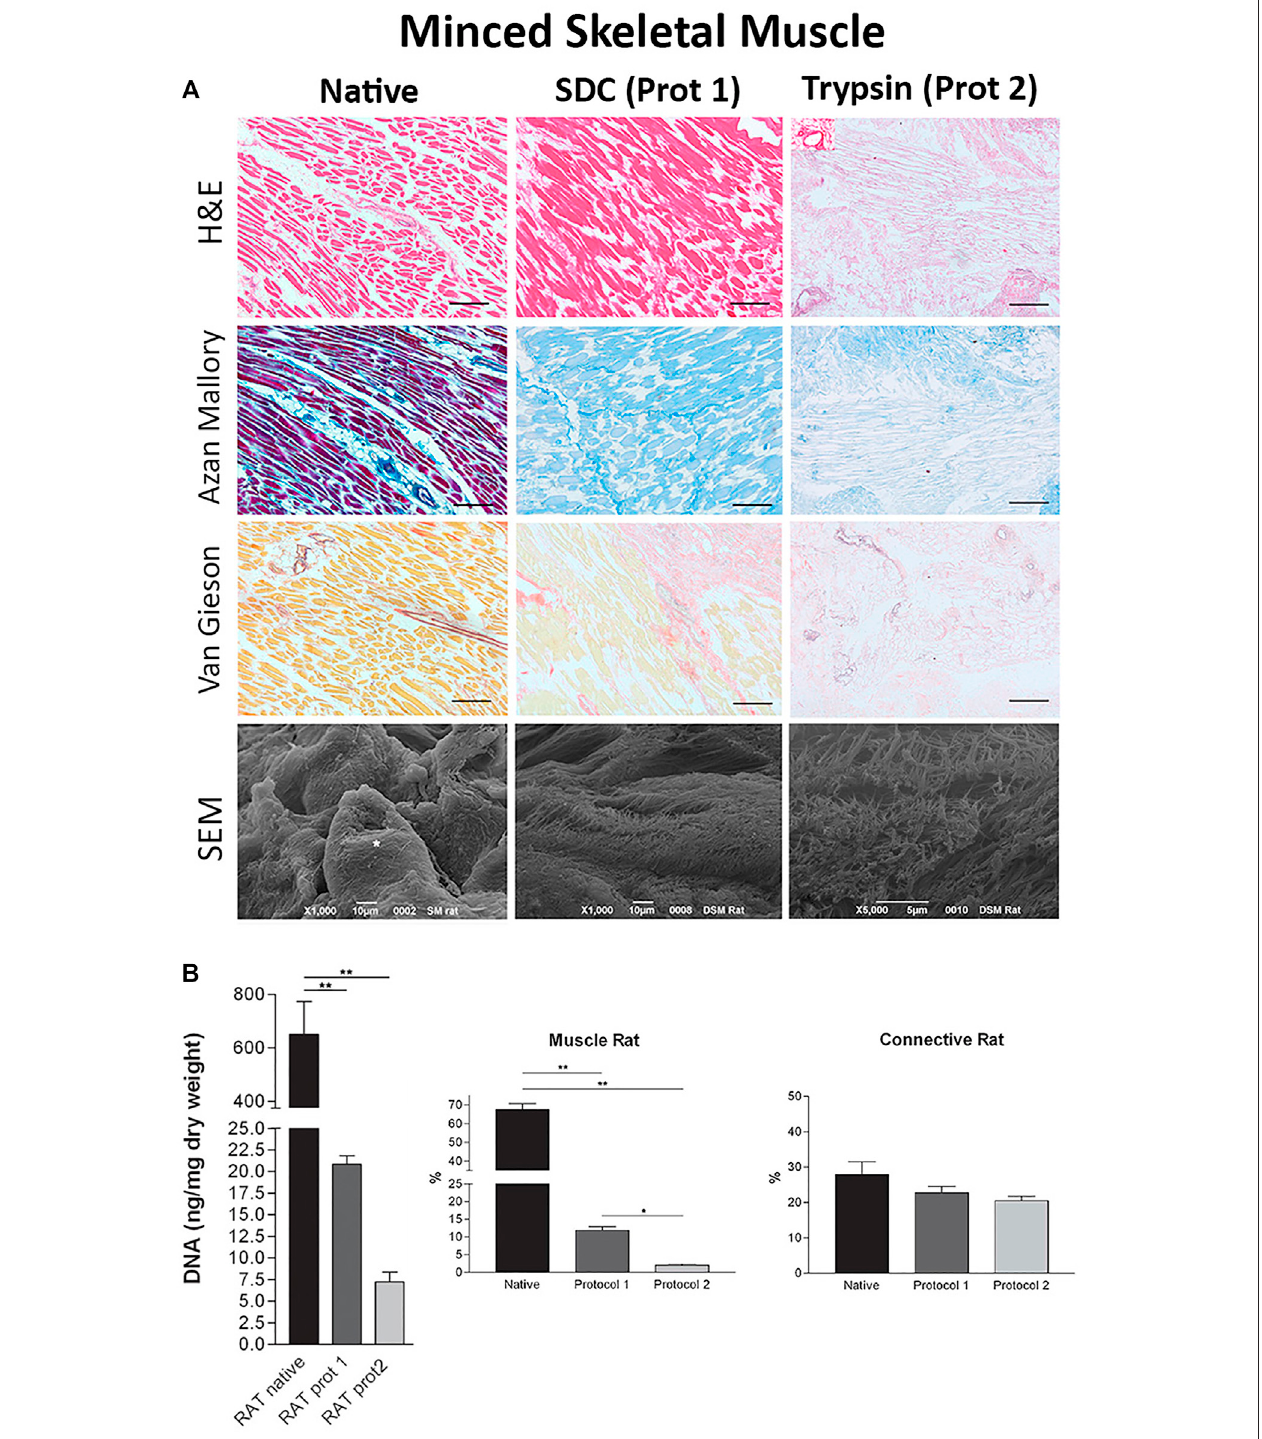
FIGURE 2 | Minced tissue decellularization protocols and outcomes (A) Tissue morphology from top to bottom: H&E staining, Azan Mallory stains, Van Gieson stains, and SEM images of minced tissuesbefore (Native, column 1) and after decellularization with SDC (Protocol 1, SDC +DNaseI, column 2) and Trypsin (Protocol 2, Trypsin/EDTA+TritonX-NH4OH,column3)protocols (B) DNA,musclecontent,andconnectivetissuecontentbeforeandafterdecellularizationusingprotocoloneand protocol 2. Figures A,B are adapted from “ Decellularized Human Skeletal Muscle as Biologic scaffold for Reconstructive Surgery ” by Porzionato et al. (2015) licensed under CC BY